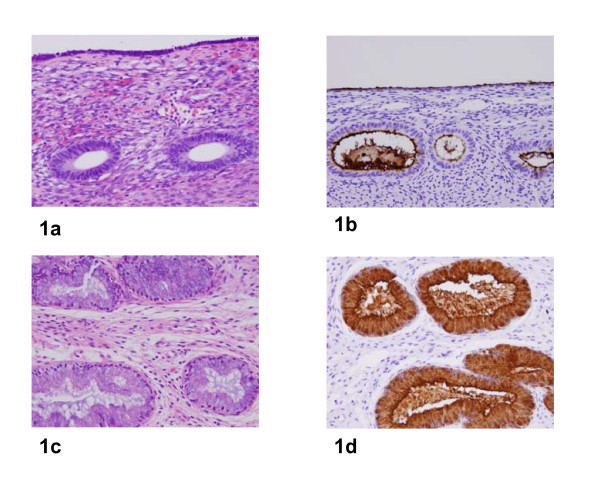
A, Normal post-menopausal endometrium (H&E, 20x); B, MUC1 immunostain in normal postmenopausal endometrium showing “pure apical” staining pattern (x20); C, normal endocervical glands (H&E, 20x); D, MUC1 immunostain in normal endocervical glands showing A/C staining pattern, (x20).